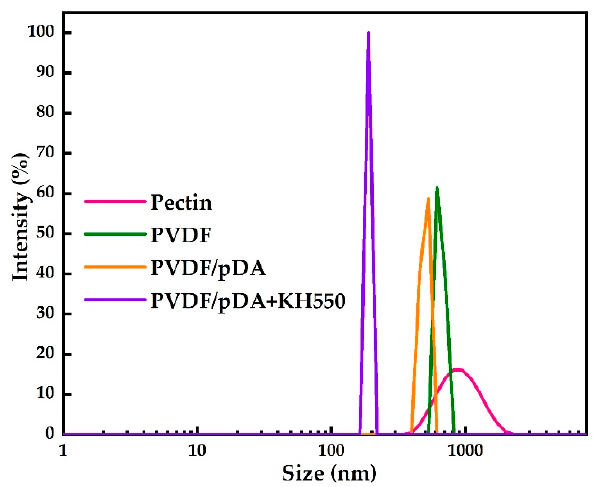
Figure 9. Particle size distribution of the pectin solution and penetrants.